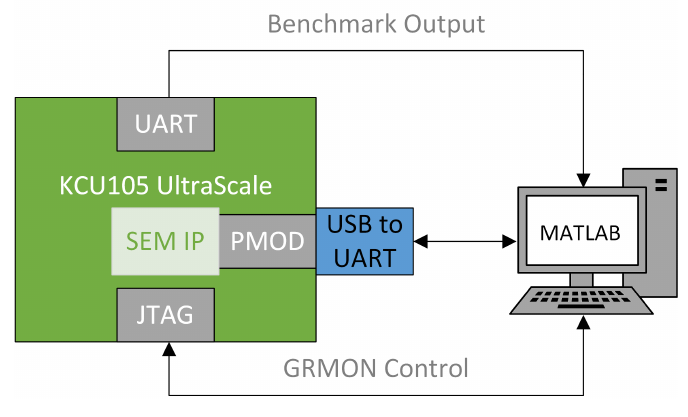
Figure 1. Experimental